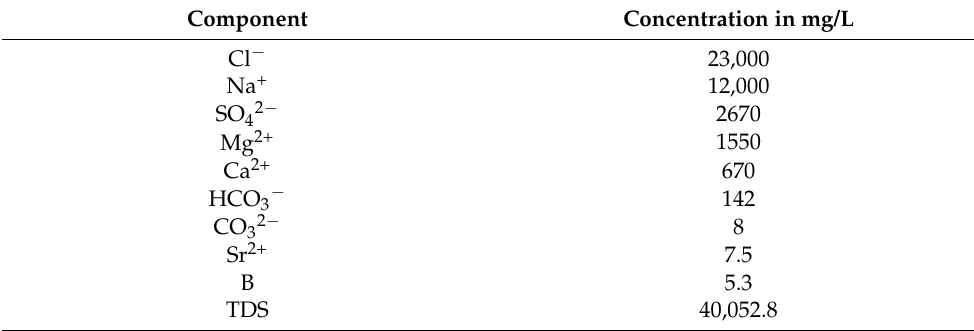
Table 2. Dissociated ion concentration of the Mediterranean Seawater [43].